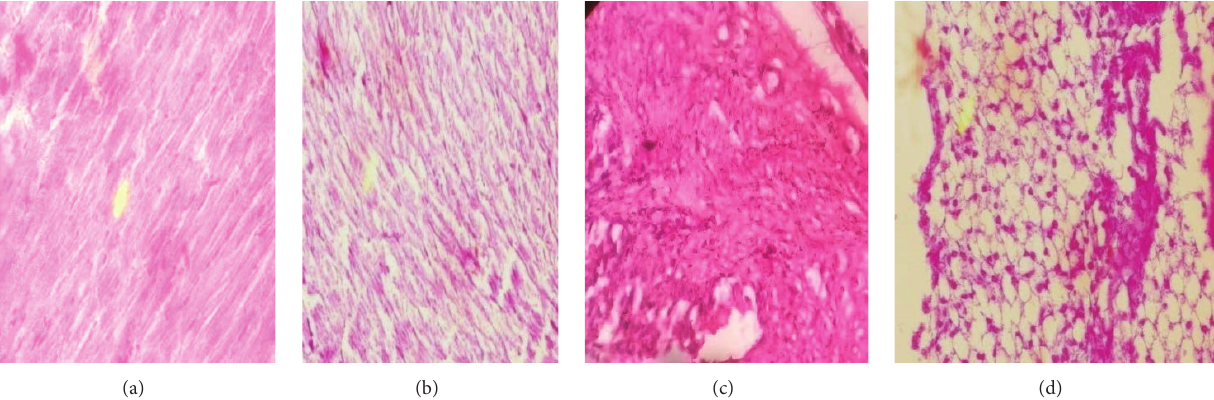
Figure 6: Histopathological changes of the myocardium and aorta. (a) The NC group rat heart revealed the noninfarcted architecture of the myocardium. (b) The HF-DC group rats showed myofibril damage and demonstrated marked edema, confluent areas of myonecrosis separation of myofibers, congested blood vessels, and mild inflammation. (c) NC group rat aorta showed the normal architecture. (d) Histopathology of HF-DC aorta showed fat cell deposition in vessel wall (atherosclerosis).